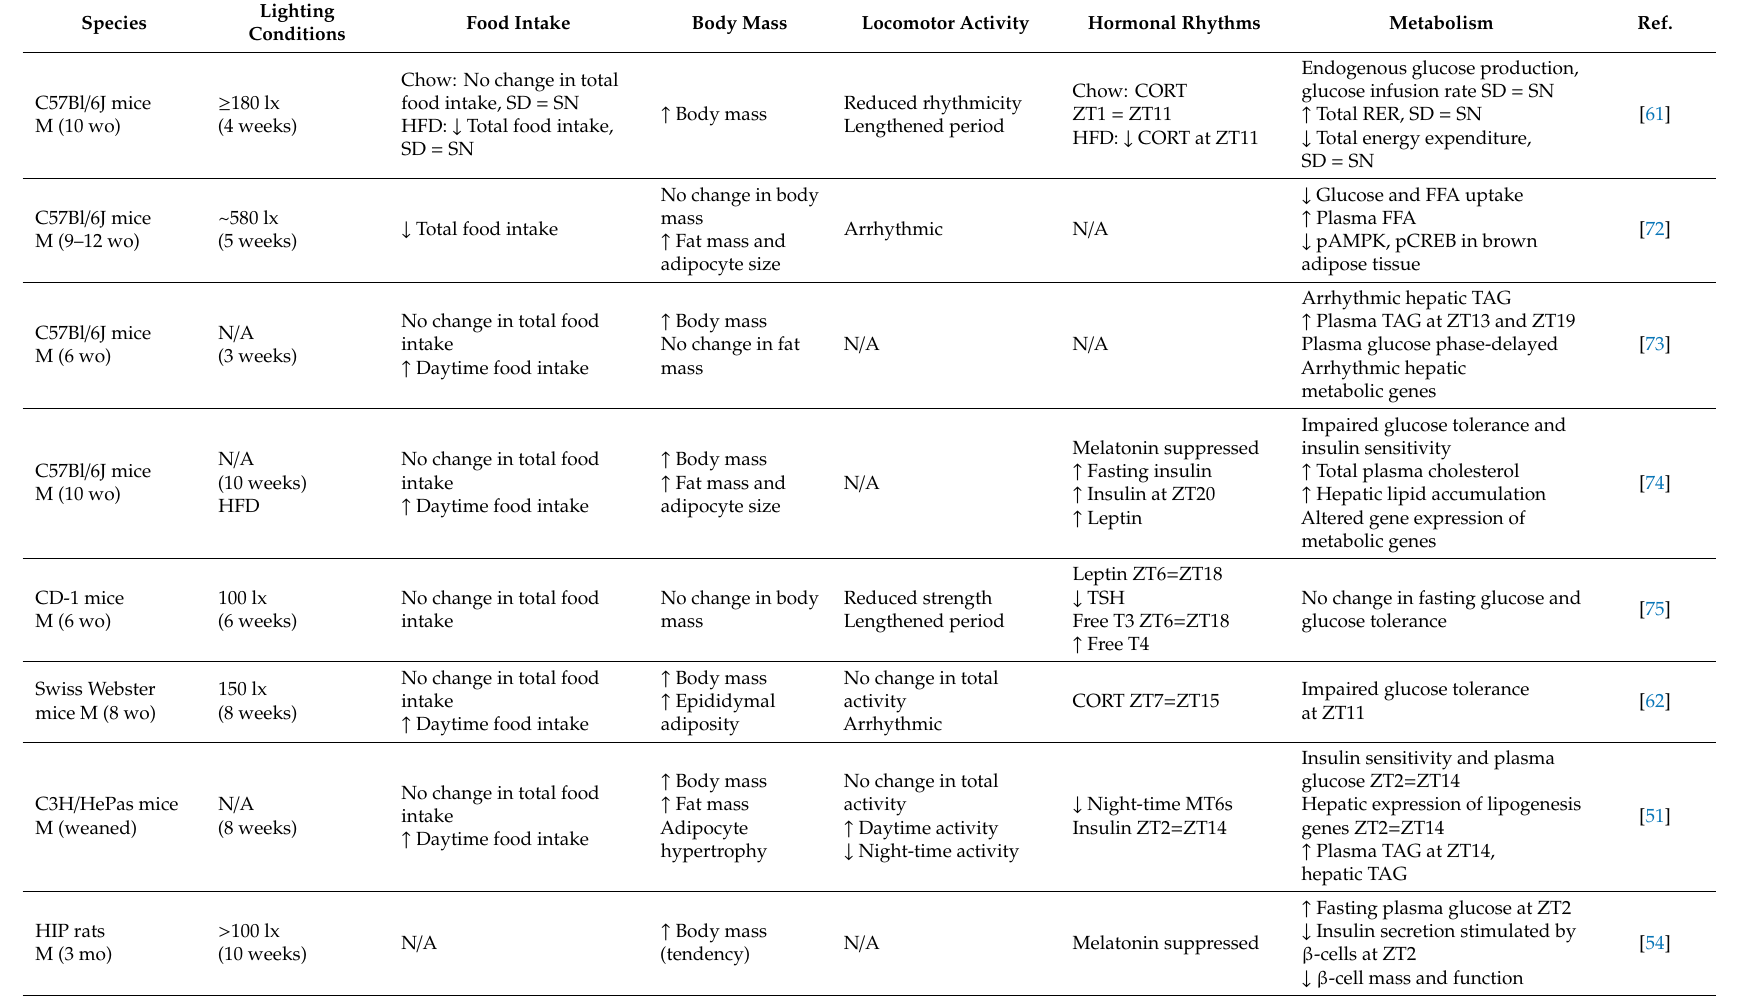
Table 1. E ff ects of constant light on behavior and physiology of mice and